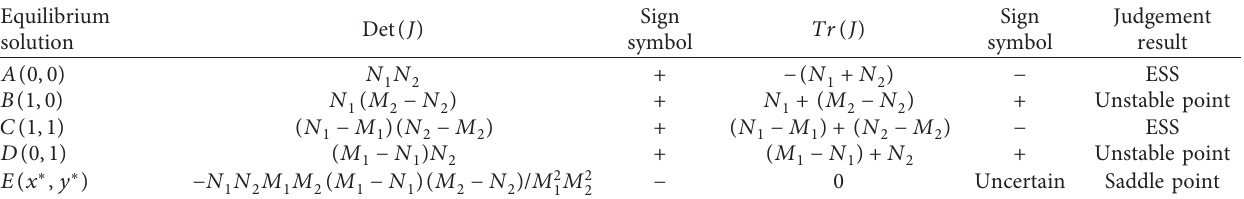
Table 6: Stability analysis of equilibrium points when M